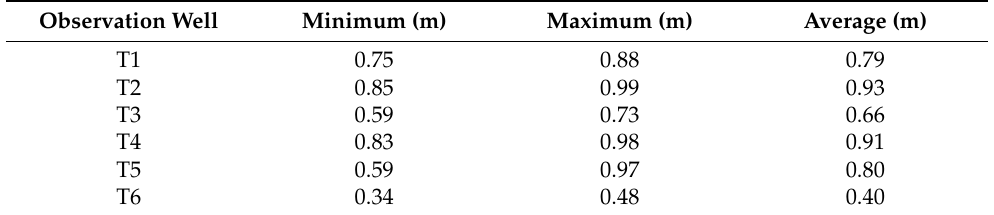
Table 2. Minimum, maximum and average water table level in meters above the cover/tailings interface.